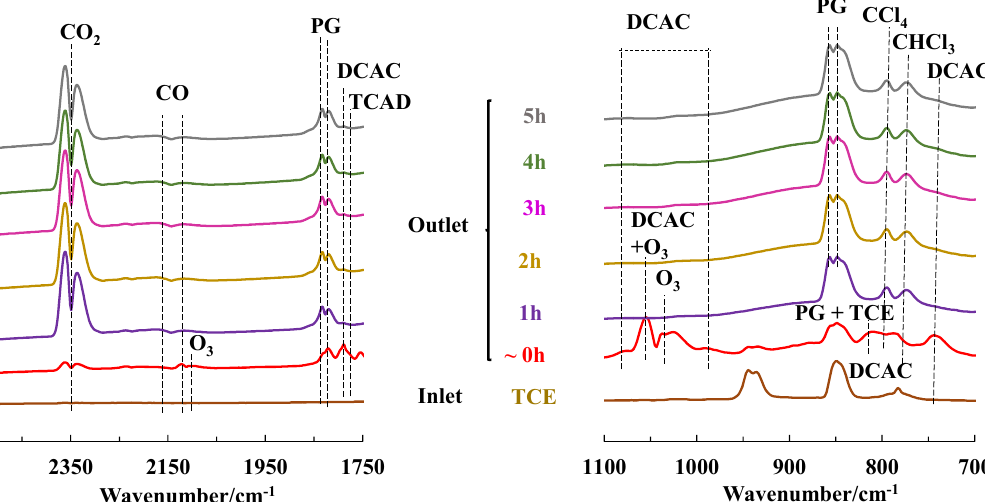
Figure 10. FT-IR spectra of the inlet TCE and outlet gaseous stream after the PPC process (RH = 0.7%) as a function of time with Ce 0.01 Mn-AT as the catalyst. PG: phosgene; DCAC: dichloroacetylchloride; TCAD: trichloroacetaldehyde.